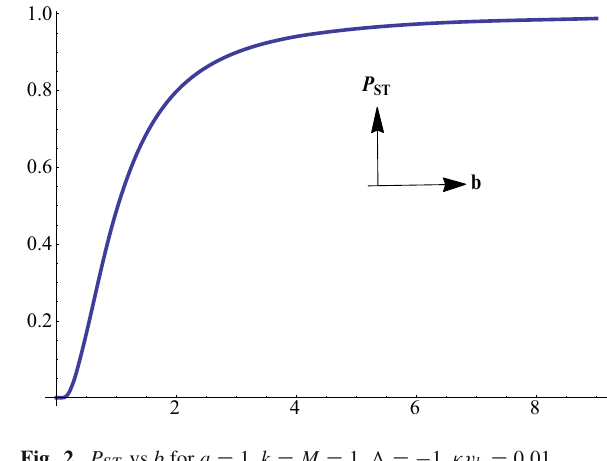
Fig. 2 P ST vs b for a = 1 , k = M = 1 ,(cid:11) = − 1 ,κv h = 0 .